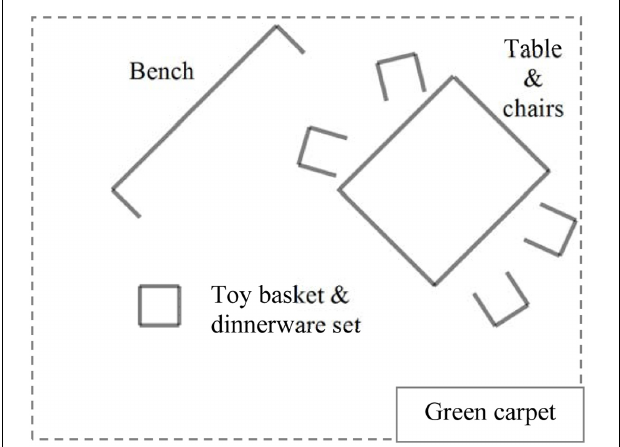
FIGURE 2 | Arrangement of the PicNic